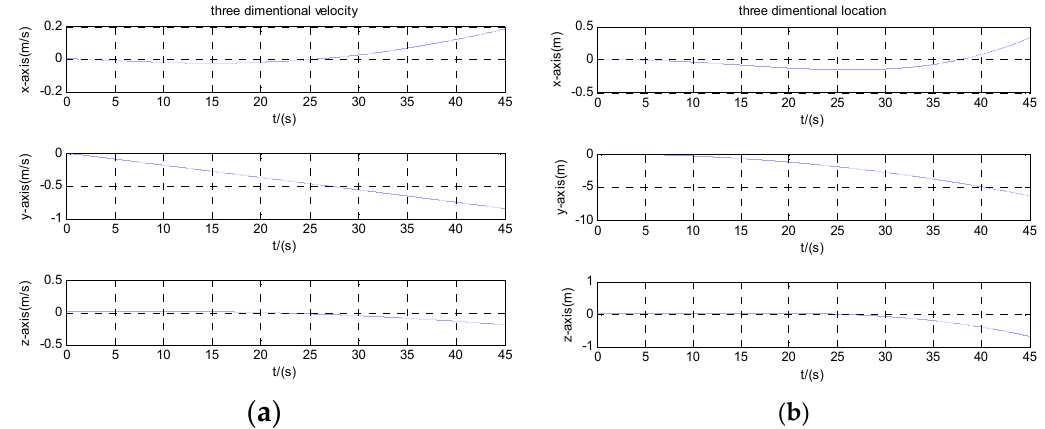
Figure 10. Velocity and position after compensation: ( a ) velocity; ( b ) position.